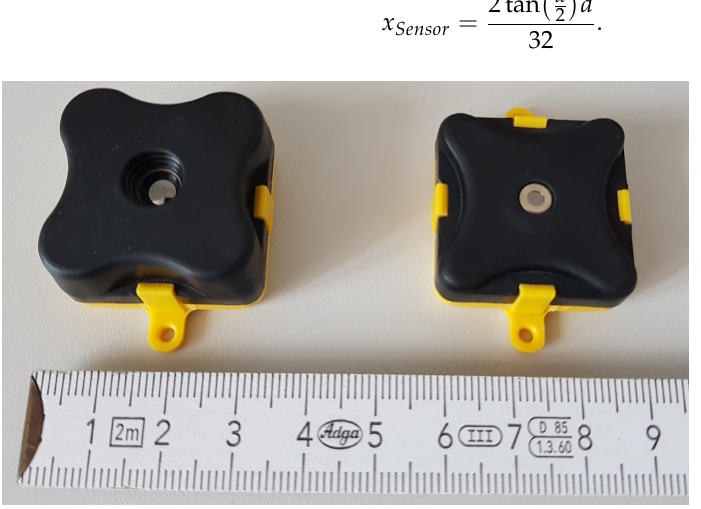
Figure 5. Teraranger Thermal 33 and